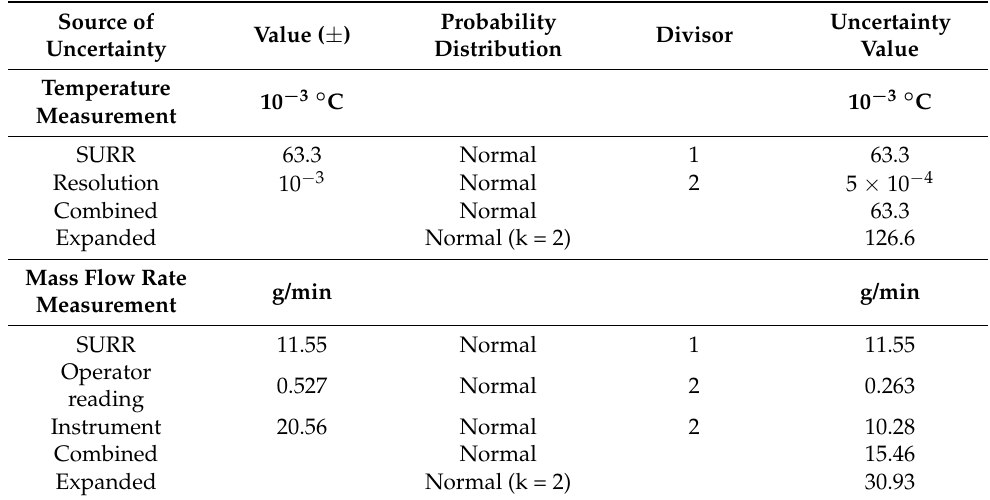
Table 2. Uncertainty budget of the power dissipation of